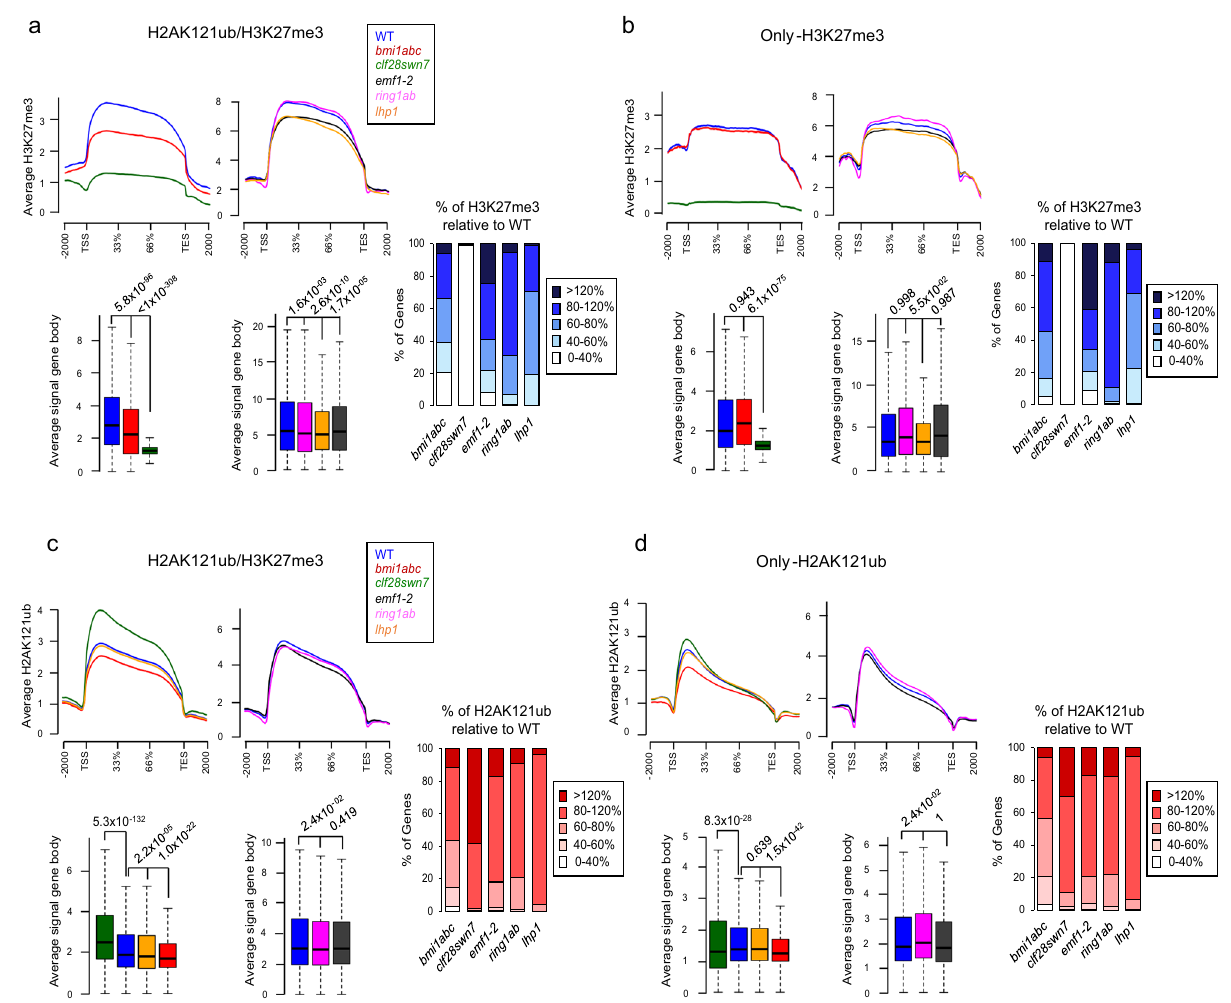
Fig. 3 H2AK121ub and H3K27me3 levels in mutant and WT seedlings. a Metagene plots of H3K27me3 coverage at H2AK121ub/H3K27me3-marked genes in the different mutants. Left panel shows results using previously published data 28 and right panel using data generated in this work (see “ Methods ” ). Bar plots indicate the percentage of genes displaying different levels of H3K27me3 marks relative to WT in each mutant. Box plots below metagene plots show average signal at gene body in the different genotypes. The median (middle line), upper and lower quartiles (boxes), and minimum and maximum values (whiskers) are indicated. P values of differences between WT and mutants according to one-sided Mann – Whitney – Wilcoxon test are also indicated. b Same as in a but for only-H3K27me3-marked genes.